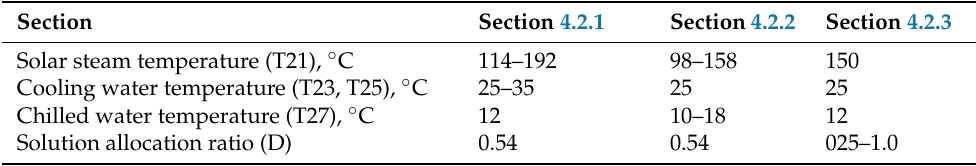
Table 7. External parameters in Section